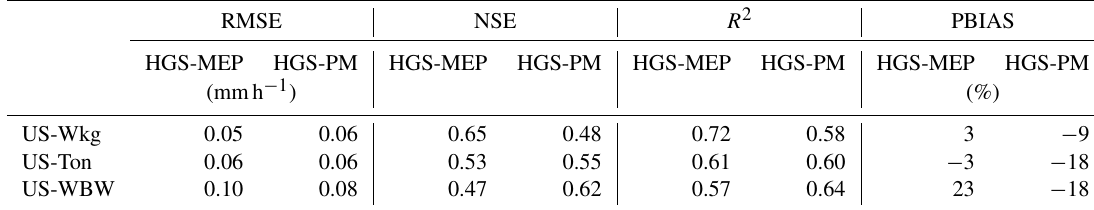
Table 6. Performance of the HGS-MEP and HGS with Penman–Monteith (HGS-PM) models when simulating half-hourly mean total terres- trial evaporation, as represented by the root-mean-square error (RMSE), Nash–Sutcliffe efficiency (NSE), coefficient of determination ( R 2 ) and percentage bias